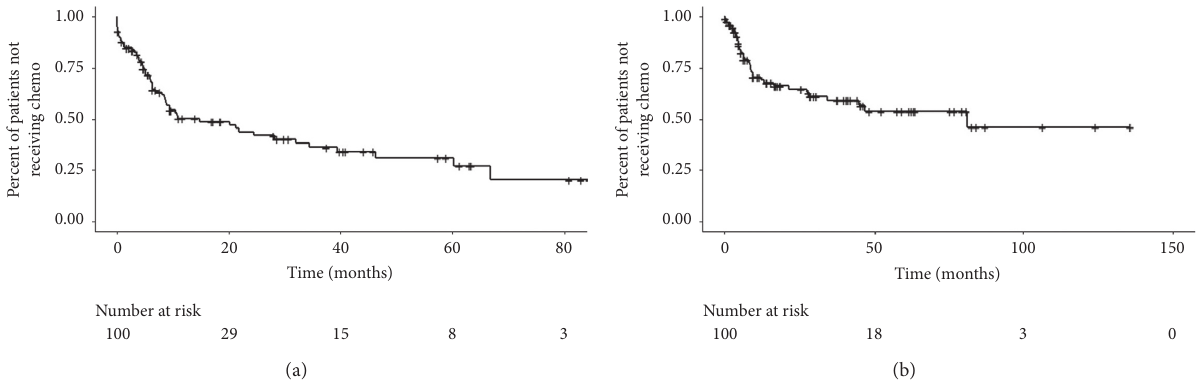
Figure 3: Chemotherapy-free interval. (a) The median systemic chemotherapy-free interval following ablation of sarcoma metastases was 14.7 months (95% CI: 8.6–34.3 months). (b) The median cytotoxic chemotherapy-free interval following ablation of sarcoma metastases was 81.3 months (95% CI: 34.3—median not